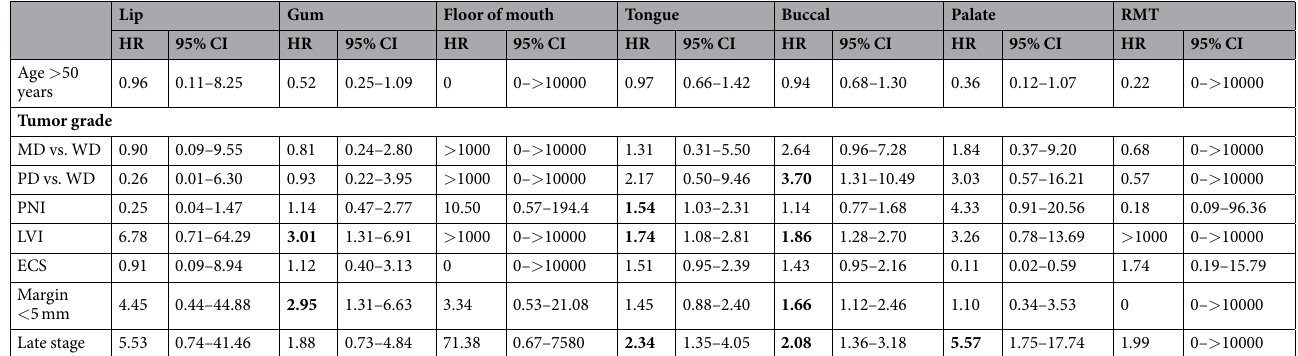
Table 3. Multivariate analysis of the impact of clinic-pathological features on the survival of oral squamous cell carcinoma patients based on subsites. Abbreviations: RMT, retromolar trigone; HR, hazard ratio; CI, confidence interval; WD, well differentiated; MD, moderately differentiated; PD, poorly differentiated; PNI, perineural invasion; LVI, lymphovascular invasion; ECS, extra-capsular